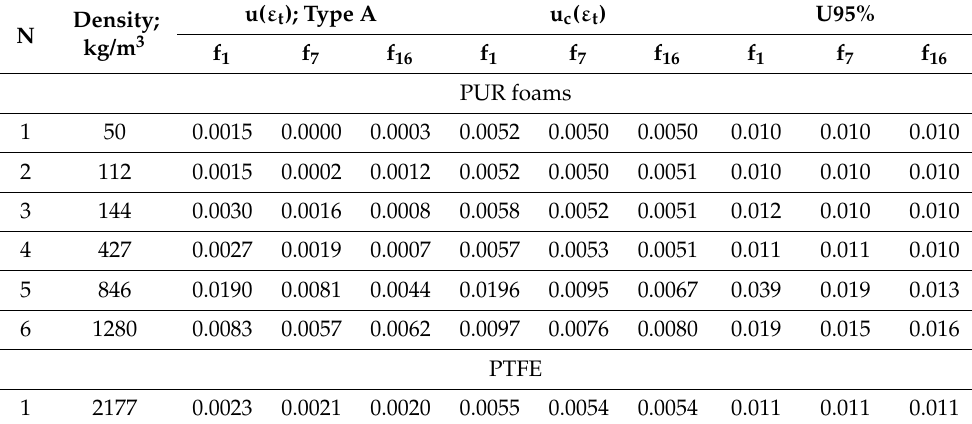
Table 5. Measurement uncertainties of the true permittivity spectra ε t